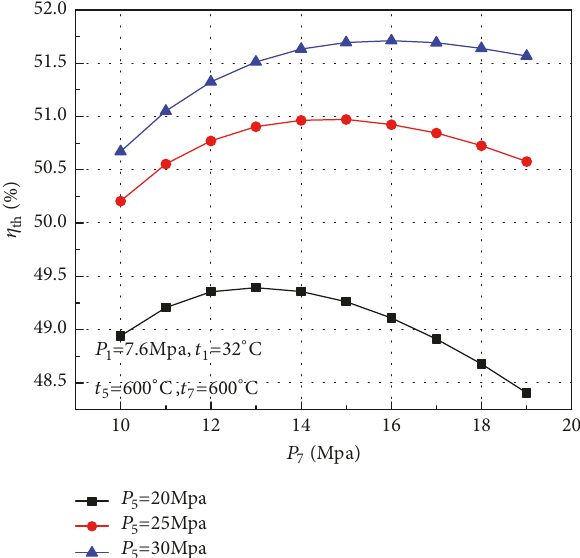
Figure 7: Effects of HPT inlet pressure on cycle efficiency at different HPT inlet temperature.